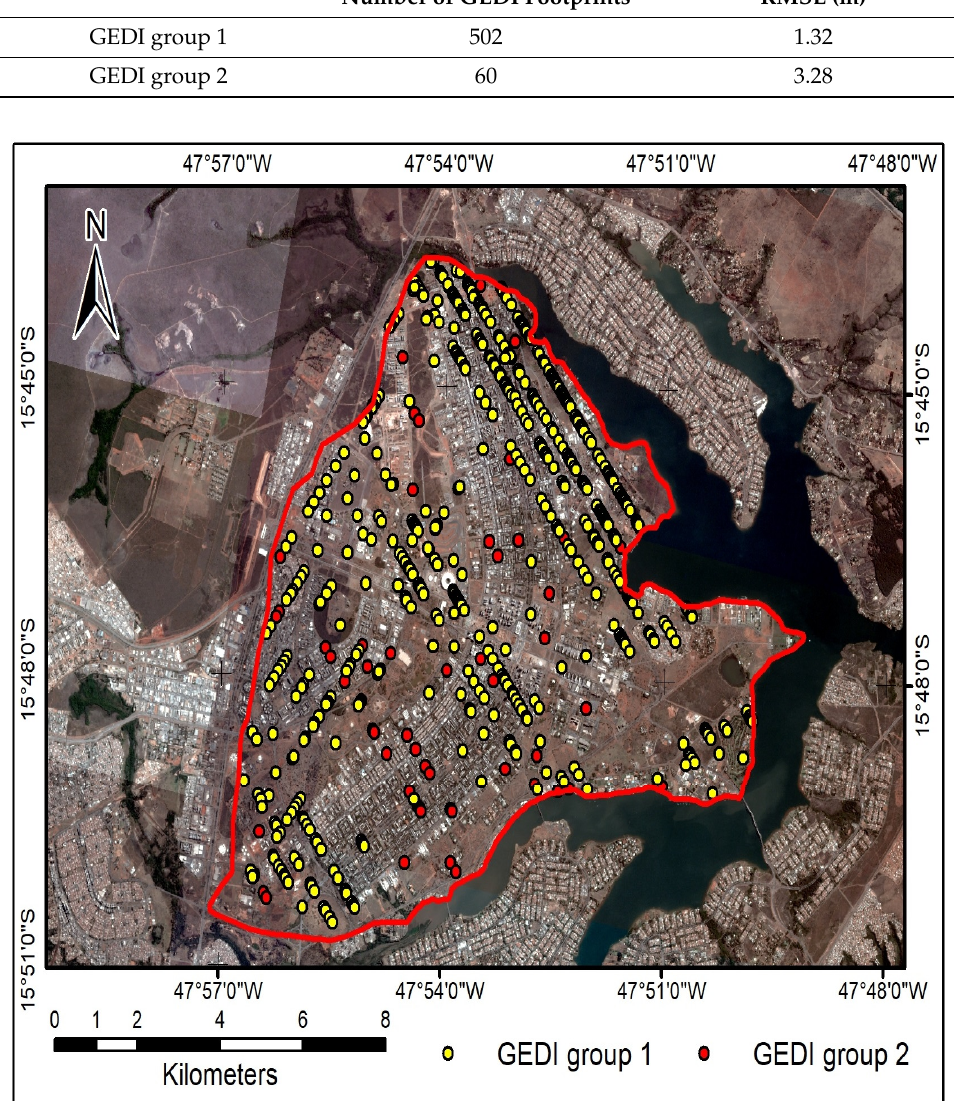
Figure 11. Location of GEDI footprint groups derived from both uncertainty removal methods. GEDI footprints from group 1 is represented in yellow dots and group 2 in red